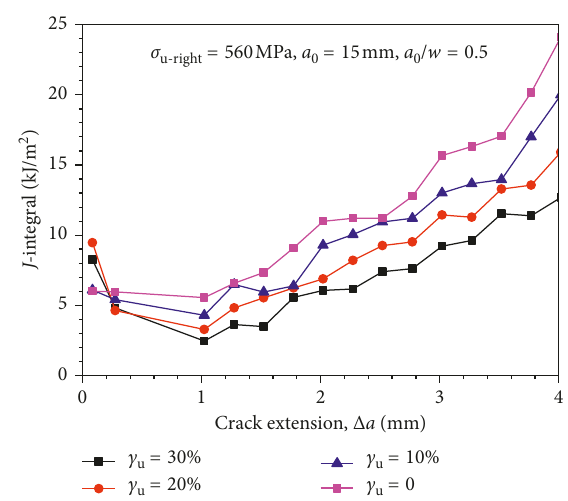
Figure 7: J - Δ a curves of ultimate tensile strength mismatch